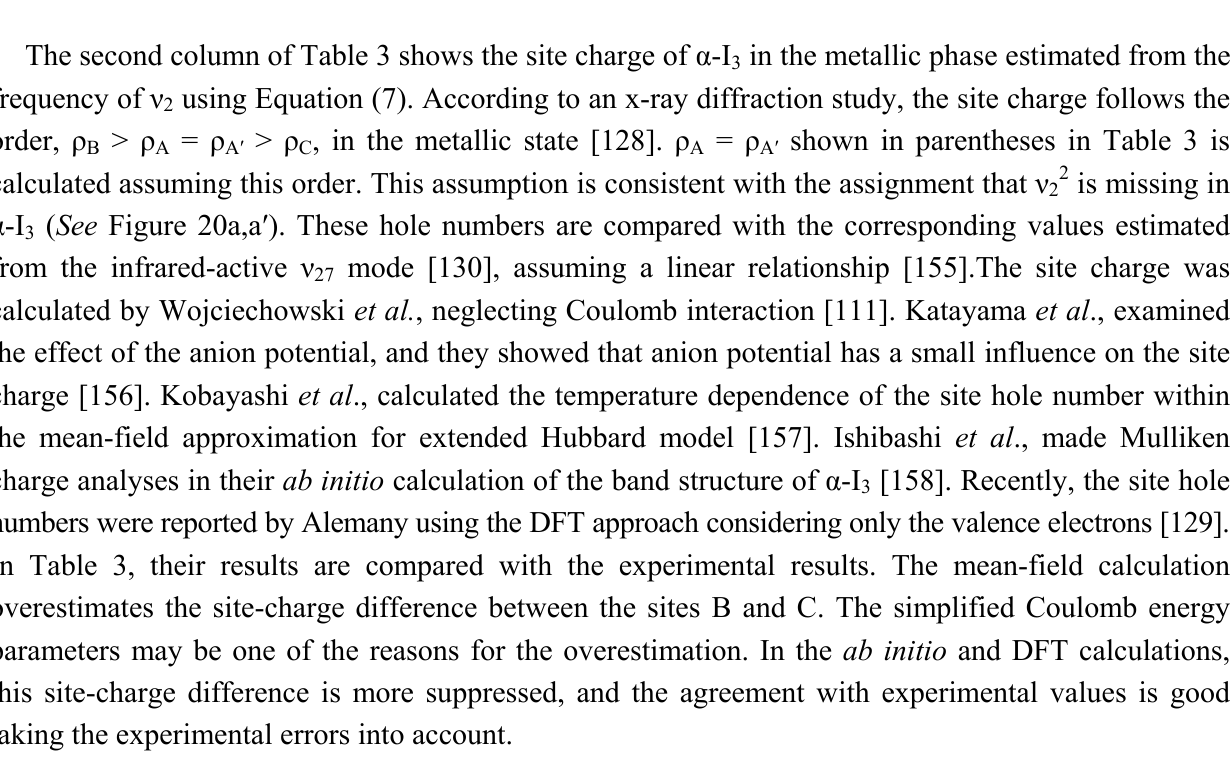
I . MF denotes mean-field 2 3